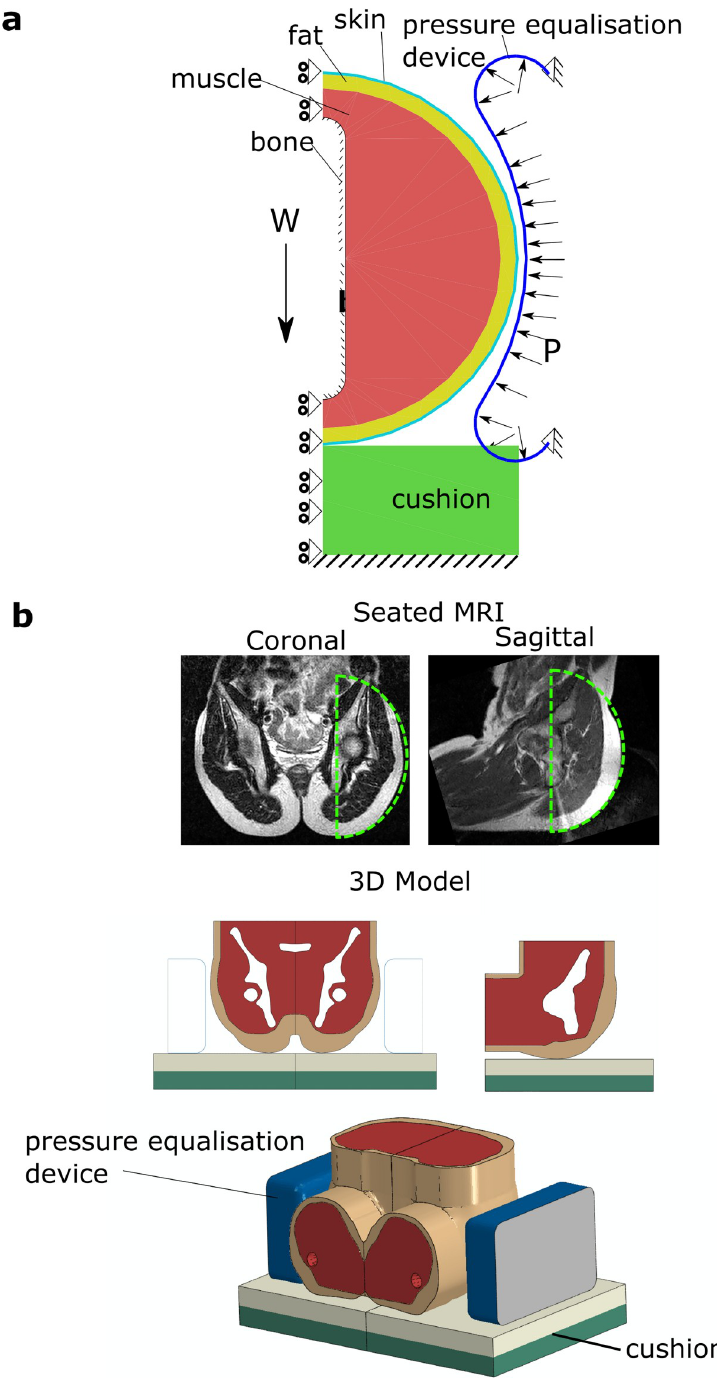
Fig 2. Finite element models. (a) An axisymmetric model of the soft tissue surrounding the ischial tuberosity. The model incorporates a rigid bony prominence, muscle, fat and skin layers interacting with a cushion and a pressure equalisation device. Axisymmetry was assumed, which allowed a force-controlled simulation of weight-bearing (W is the load borne by the ischial tuberosity). The pressure equalisation device was modelled as an air-filled chamber with a controllable internal pressure, P. (b) The axisymmetric region modelled is shown superimposed on saggital and coronal MR images of a seated male (top). A 3D model was generated from the MR images to assess 3D deformations